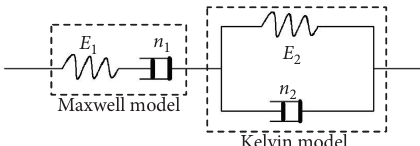
Figure 9: Physical composition of the Burgers Te E and η , respectively, represent the elastic modulus of 2 2 elastic element and the viscosity coefcient of viscous el- ement in the Kelvin model.